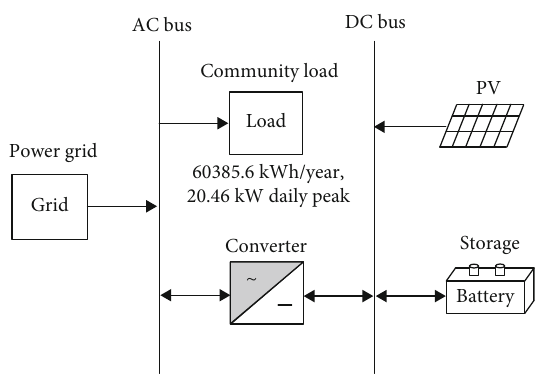
Figure 31: Schematic diagram for the PV grid-connected minigrid system with